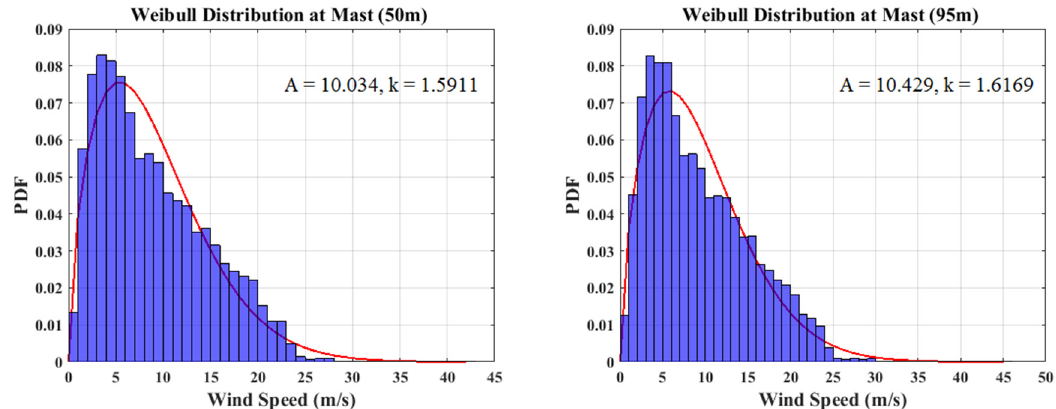
Figure 6. Weibull distribution from 1 April 2016 to 1 April 2017 at mast heights of 50 m and 95 m.